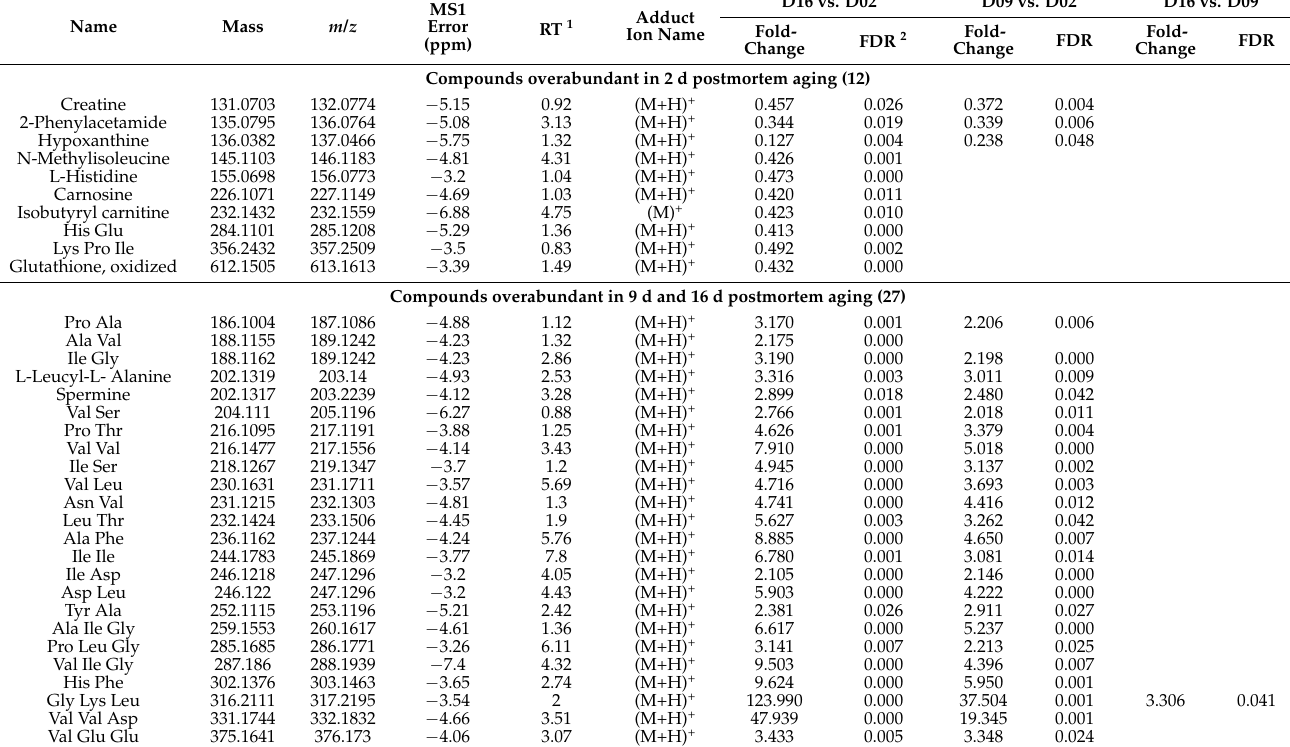
Table 2. Tentatively identified metabolites that have changed significantly among the three aging treatments.